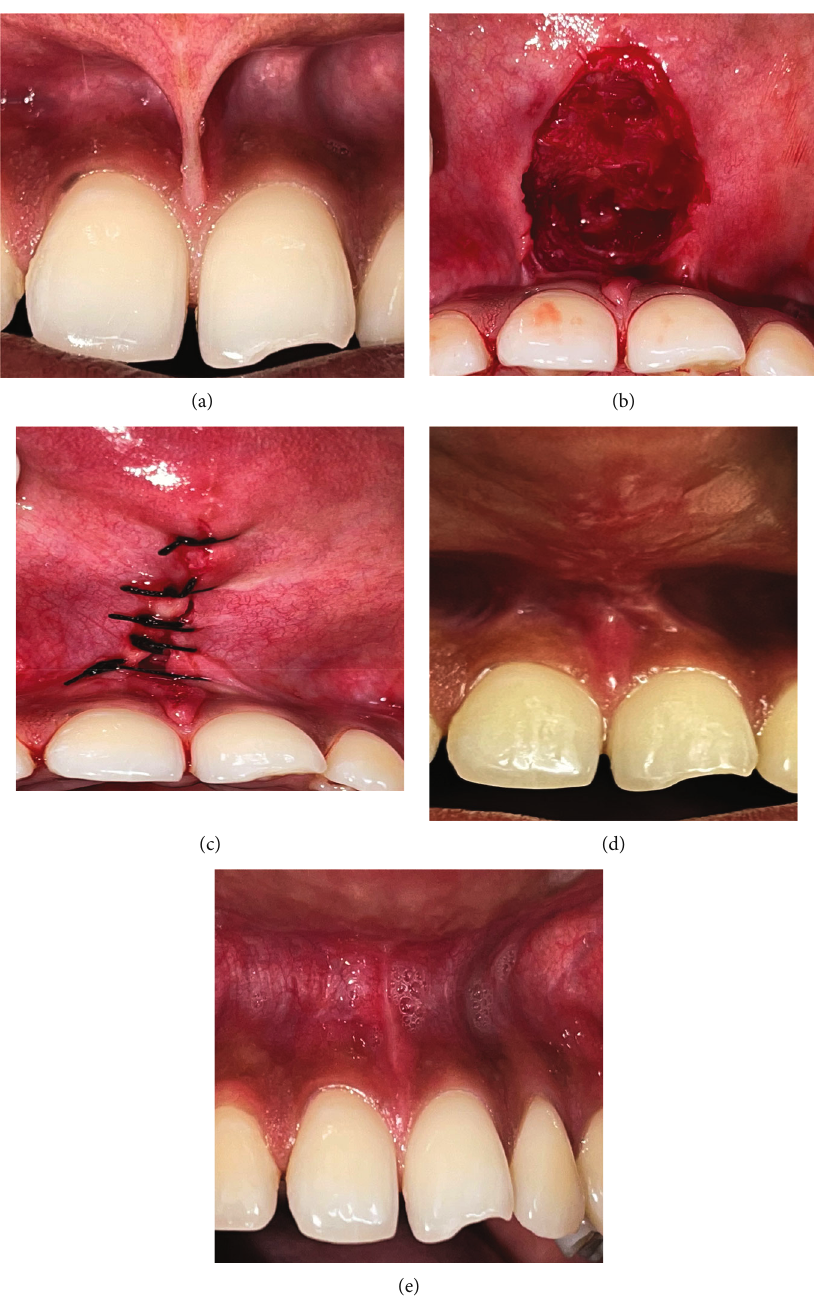
Figure 1: Clinical images of scalpel-treated patients on preoperative and postoperative days, 1, 7, and 30. (a) Preoperative. (b) Immediate postoperative. (c) Sutures placed. (d) 7-day postoperative. (e) 1-month